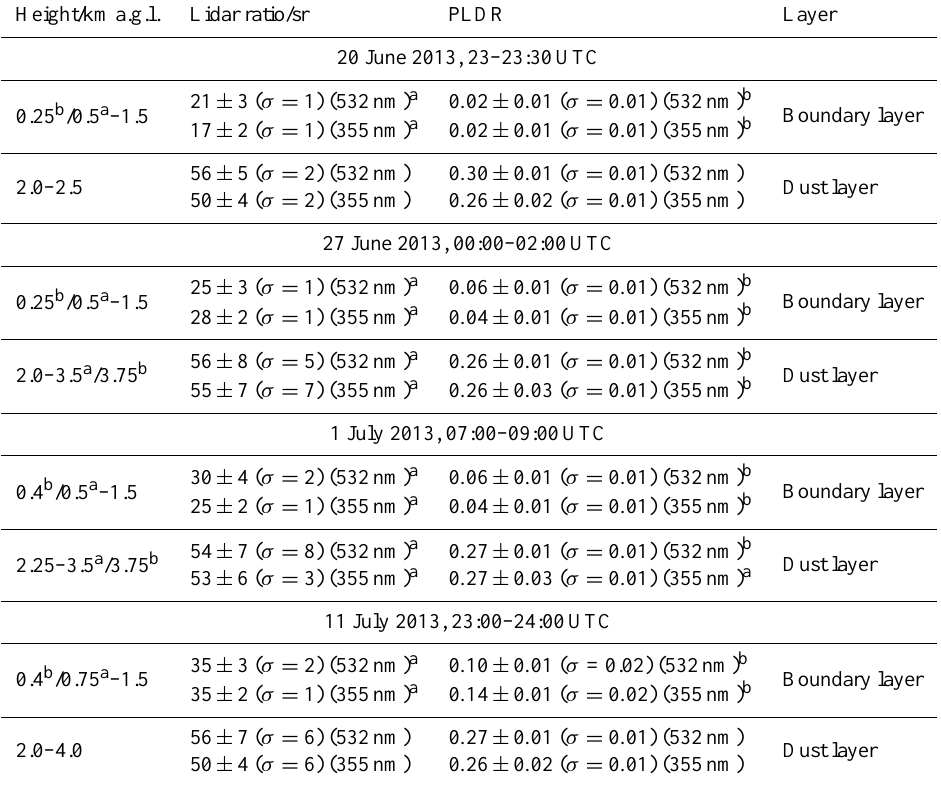
Table 1. Layer mean values for the case studies of lidar ratio S p and particle linear depolarization ratio δ p including systematic errors ( ± ), the standard deviations of the values within the height range ( σ ) indicating the variability of the values within the layer and the considered aerosol